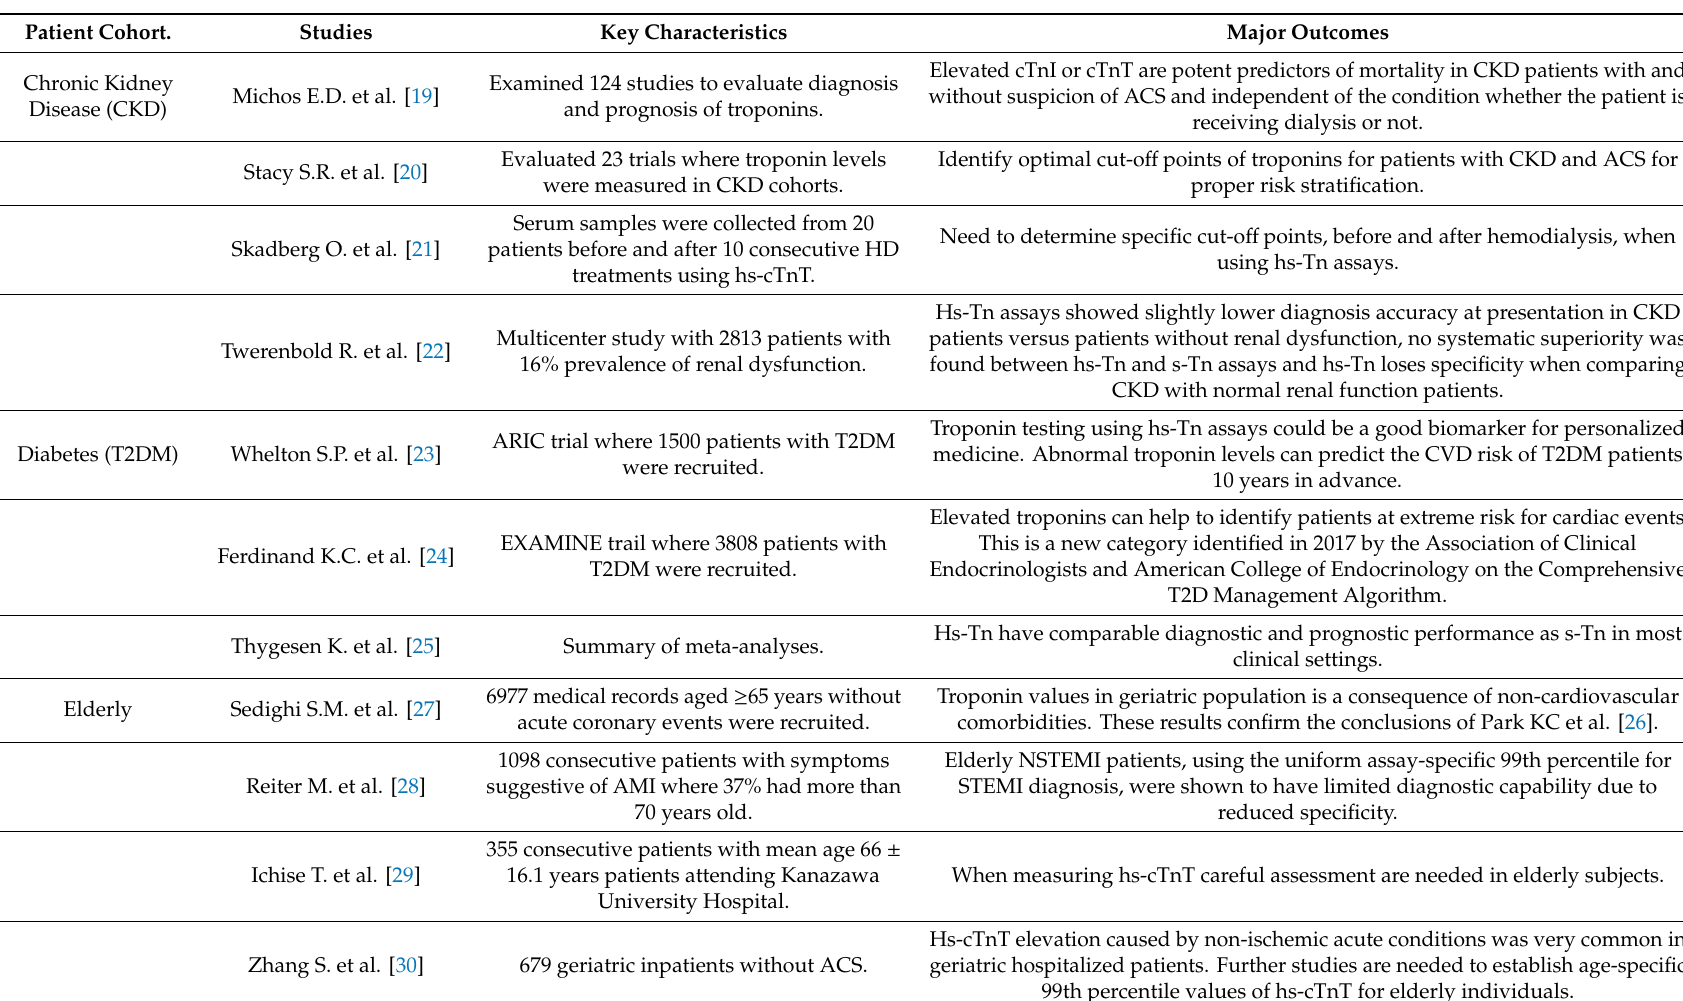
Table 1. Summary of the review process regarding diagnosis and prognosis of troponin in high-risk patients. Patient